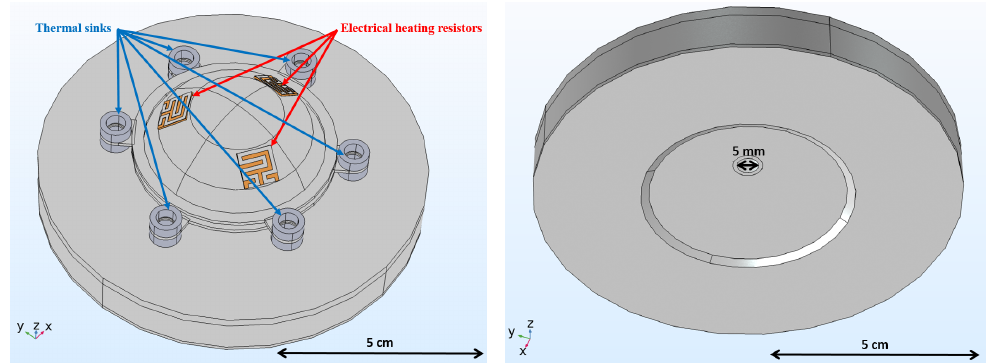
Figure 4. Cavity radiometer, with a 5 mm diameter circular precision aperture, viewed from the top ( left ) and bottom ( right ). The cavity is in Aluminium, thermal sinks are made of Permaglas R (cid:13) , and electrical heating resistors are modeled as a Constantan wire on a Polyimide layer.